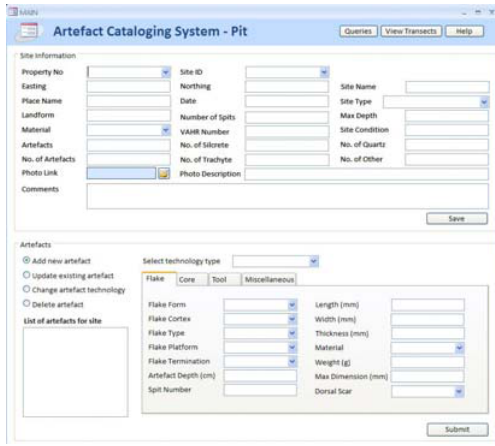
Figure 5. Test pit desktop database user interface